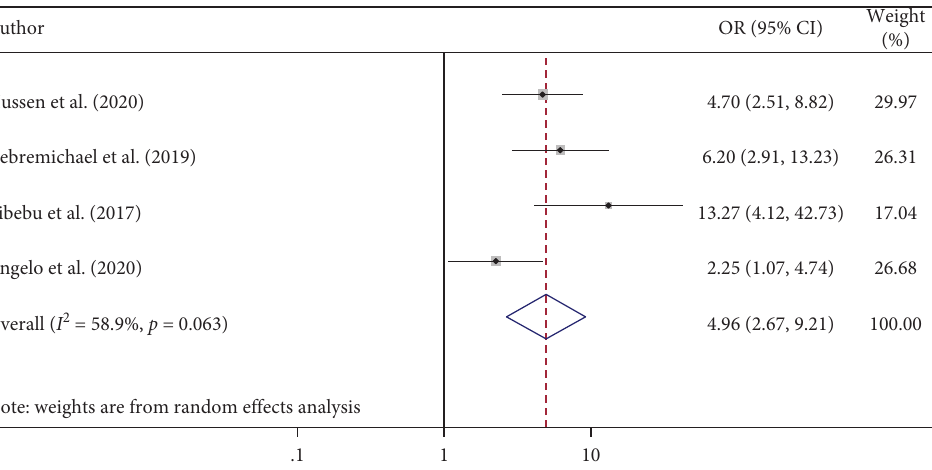
Figure 5: The pooled odds ratio of the association between hypertensive patient’s knowledge and self-care practice among hypertensive patients in Ethiopia.